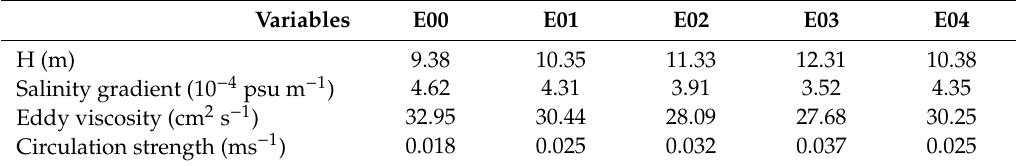
Table 4. The comparison of the gravitational circulation strength after the channel deepening. Variables E00